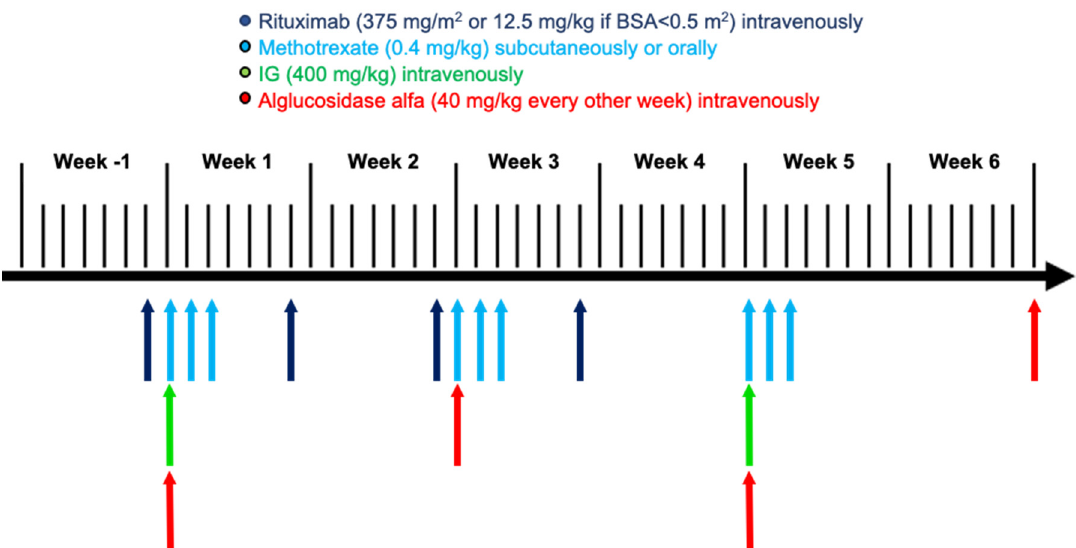
Figure 1. Scheme of the first 6 weeks of the treatment regimen used for the study’s participants, which includes immune tolerance induction along with enzyme replacement therapy. Body surface area (BSA), immunoglobulin (IG).